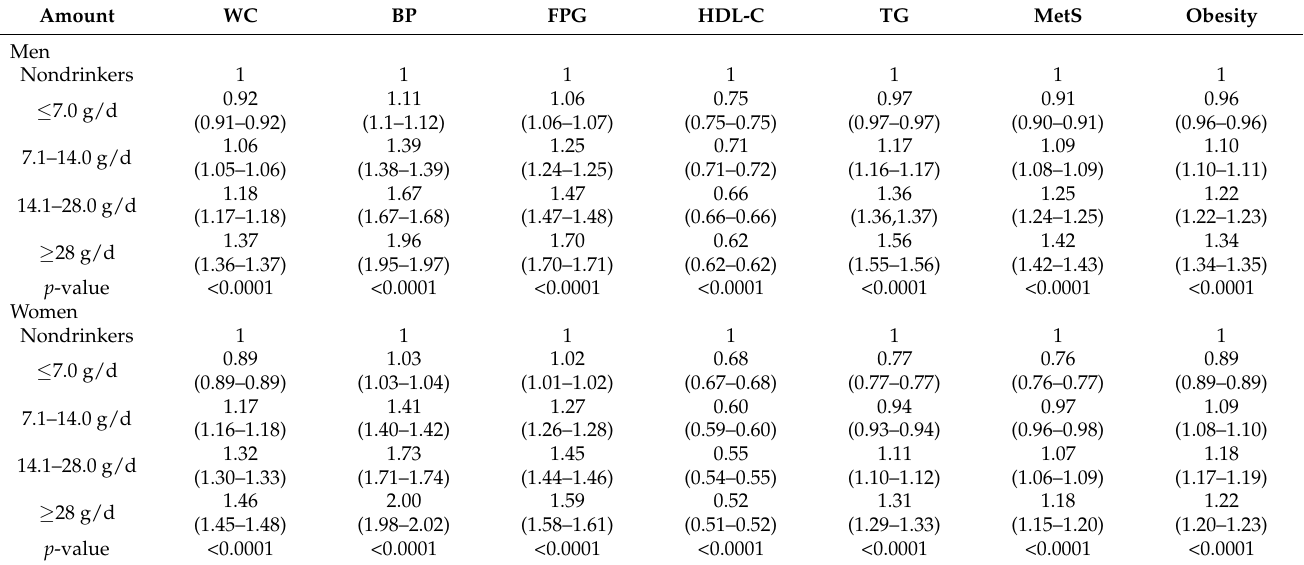
Table 3. Odds ratios of metabolic syndrome and obesity according to alcohol consumption.